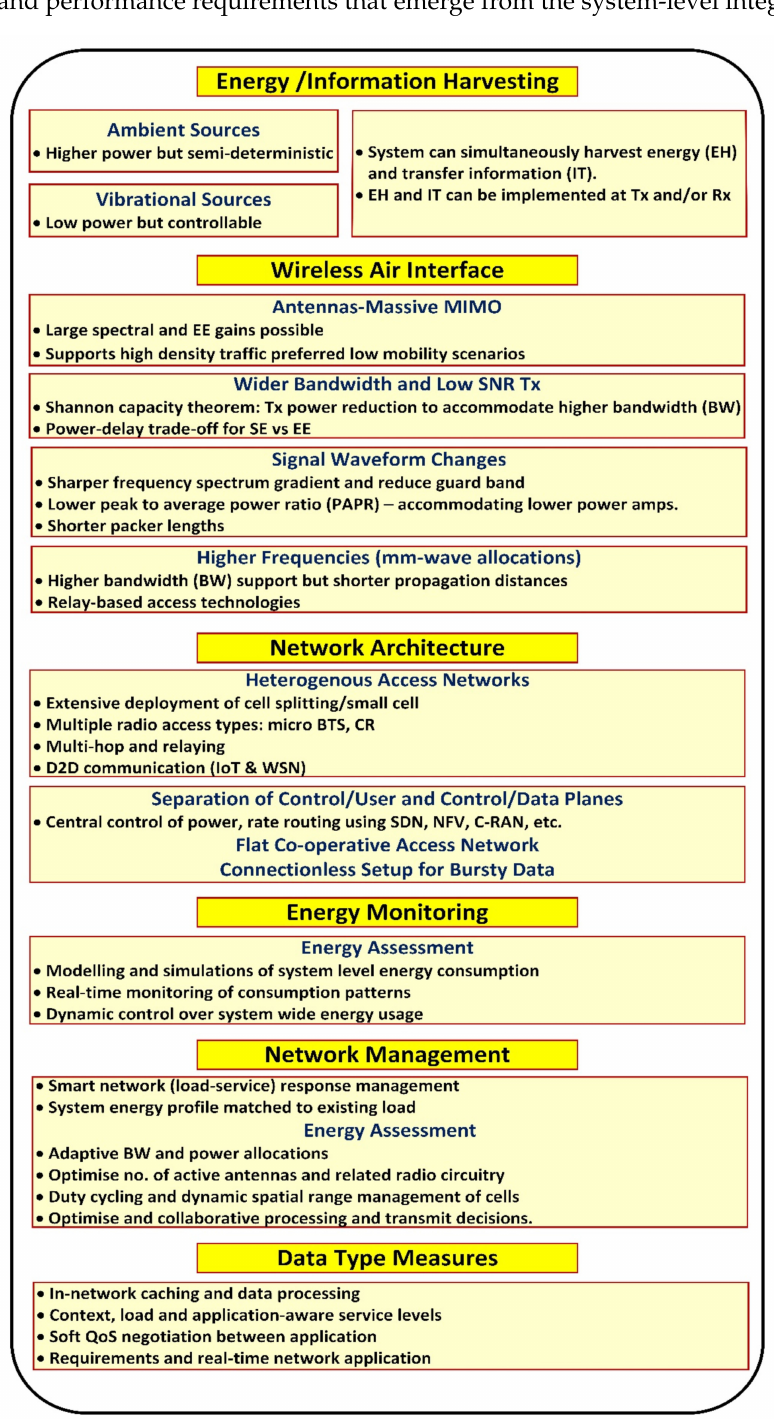
Figure 8. Network-wide green measures toward an EH Framework. Energy outage probability analysis toward EH: Existing literature on EHD restricts evaluating performance measures such as energy outage probability (EOP) to the